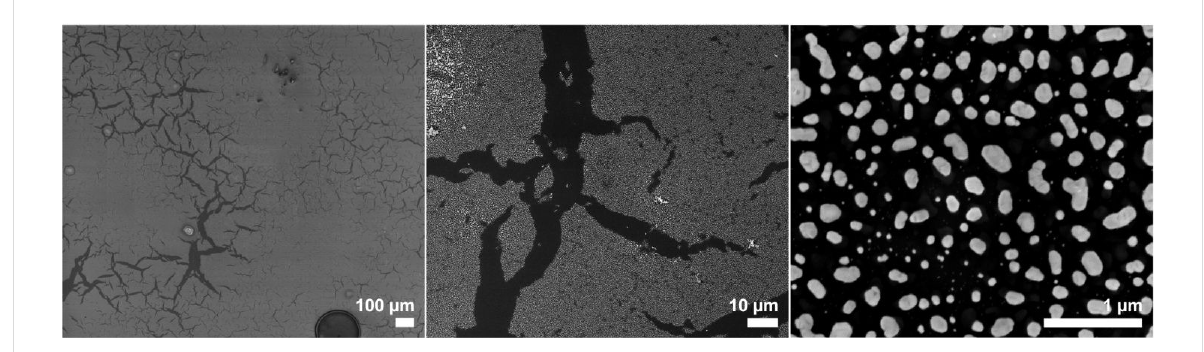
Figure 10: SEM images with different magnifications of a spin coated film of “liquid bright gold” on Si[111] after annealing at 650 °C for 1 h.